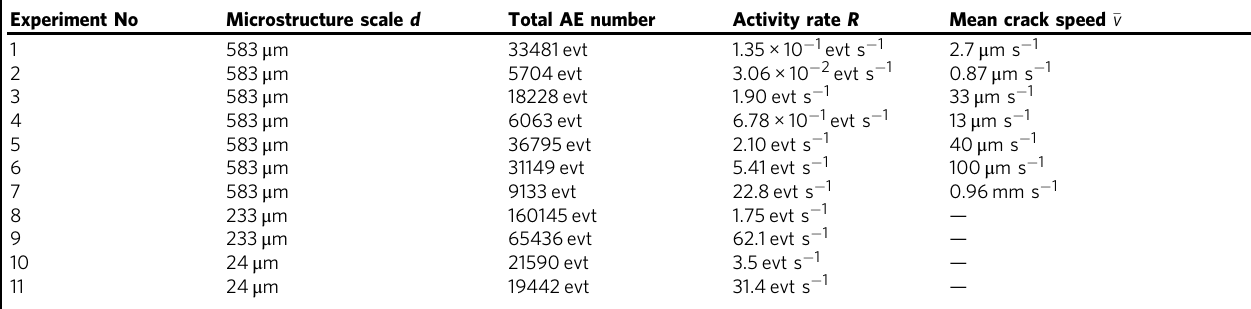
Table 1 Synthesis of the samples and experiments analyzed here Experiment